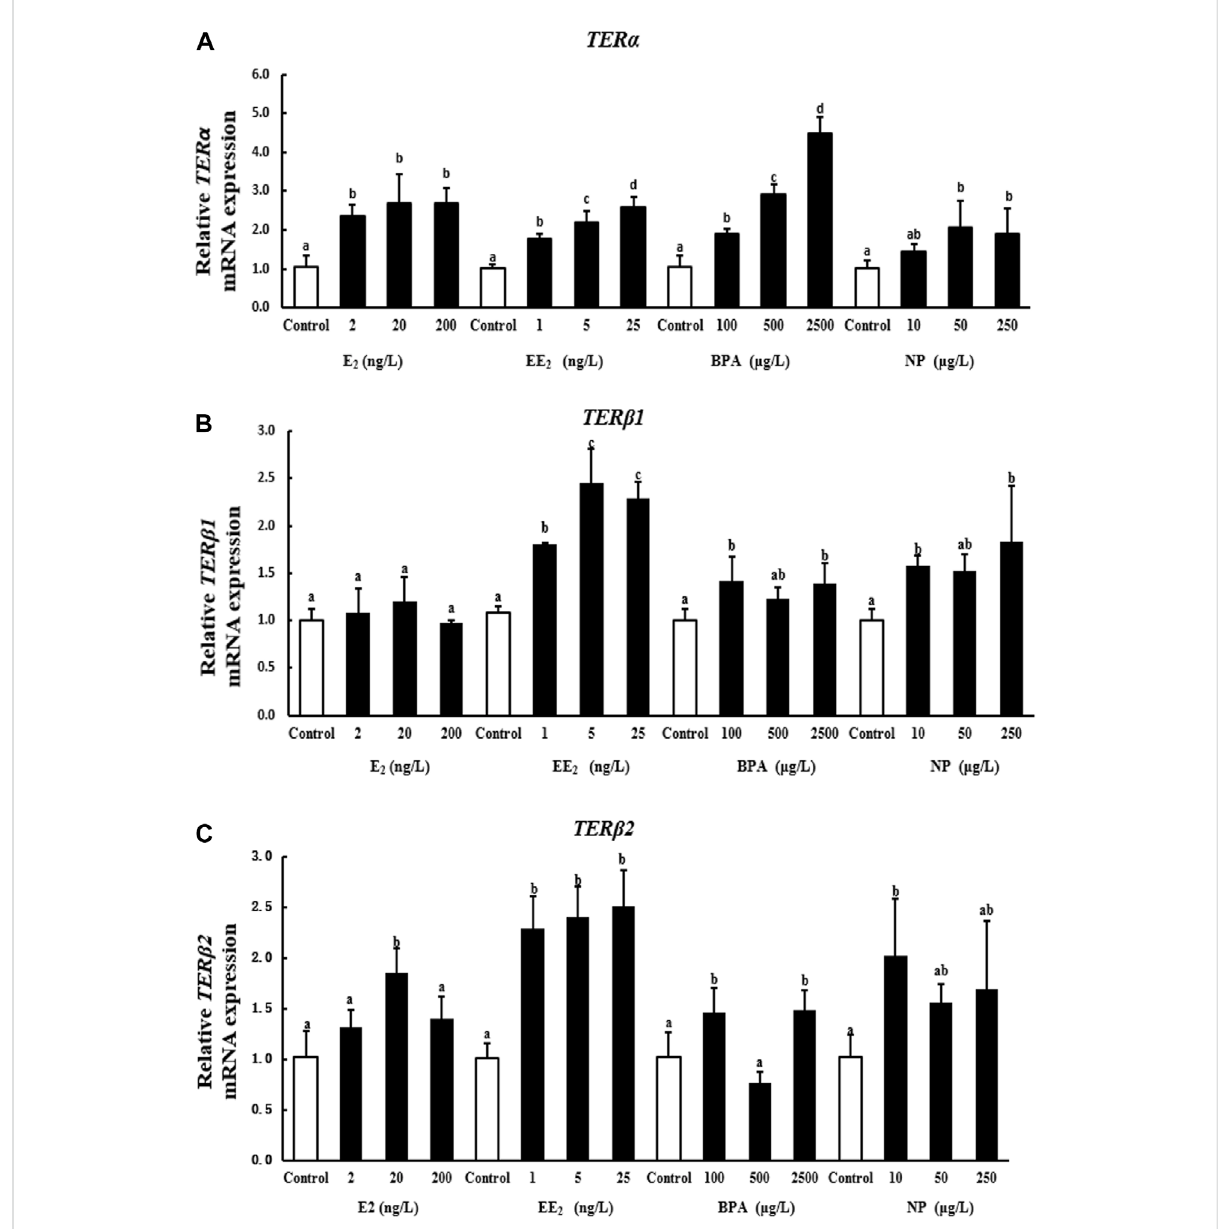
FIGURE 2 Effects of EDCs on the expression levels of ter α (A) , ter β 1 (B) , and ter β 2 (C) in the brain of T. albonubes . Columns with different letters are signi fi cantly different at p < 0.05 according to one-way ANOVA followed by Dunnett ’ s